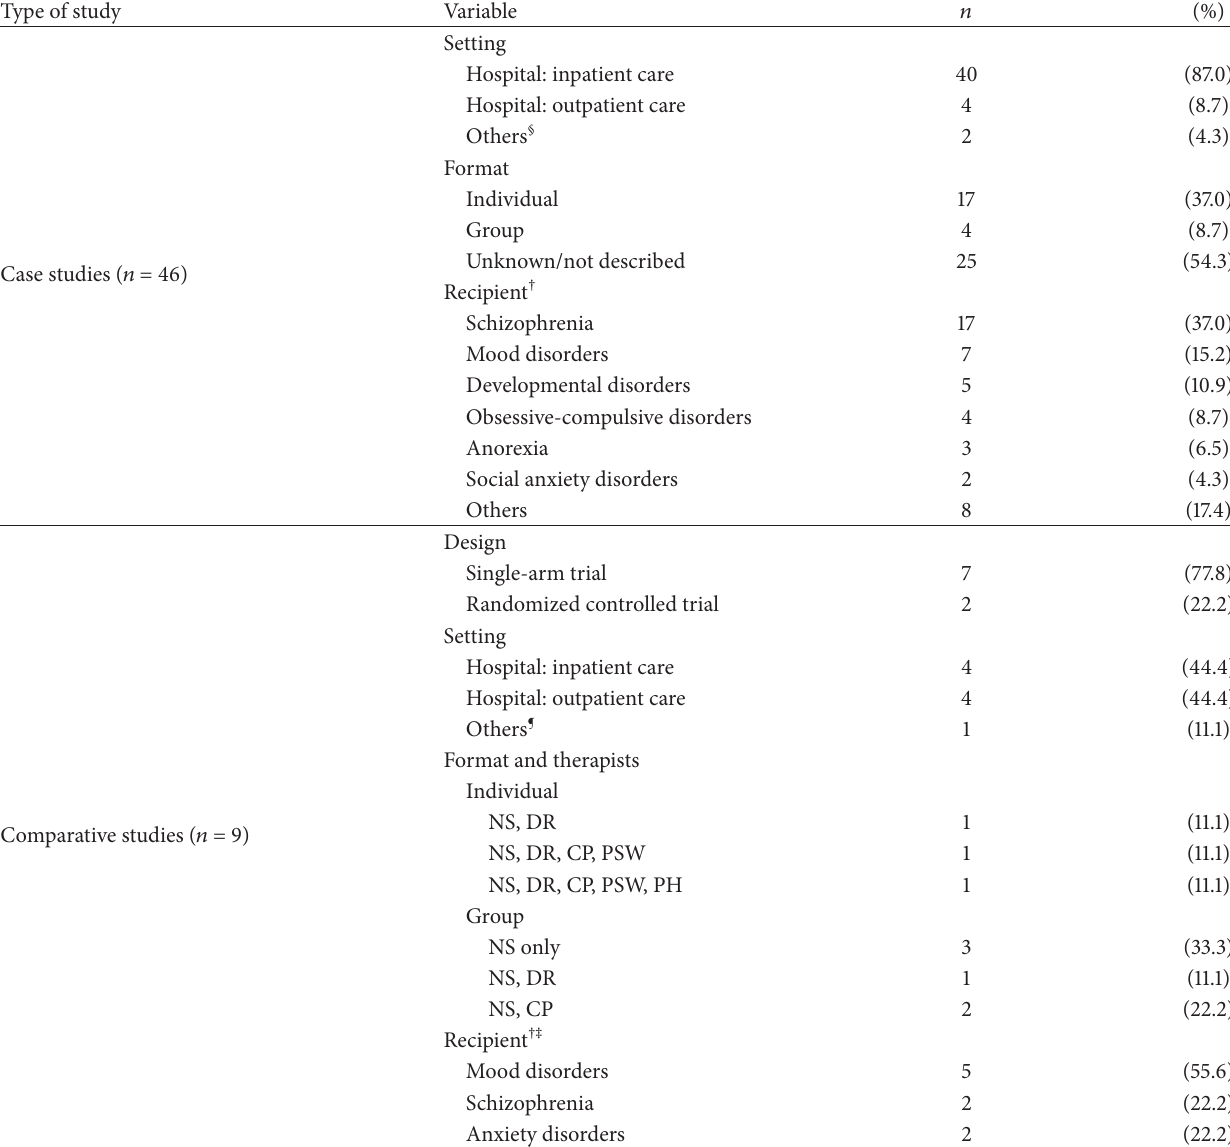
Table 1: Summary of the case studies and comparative